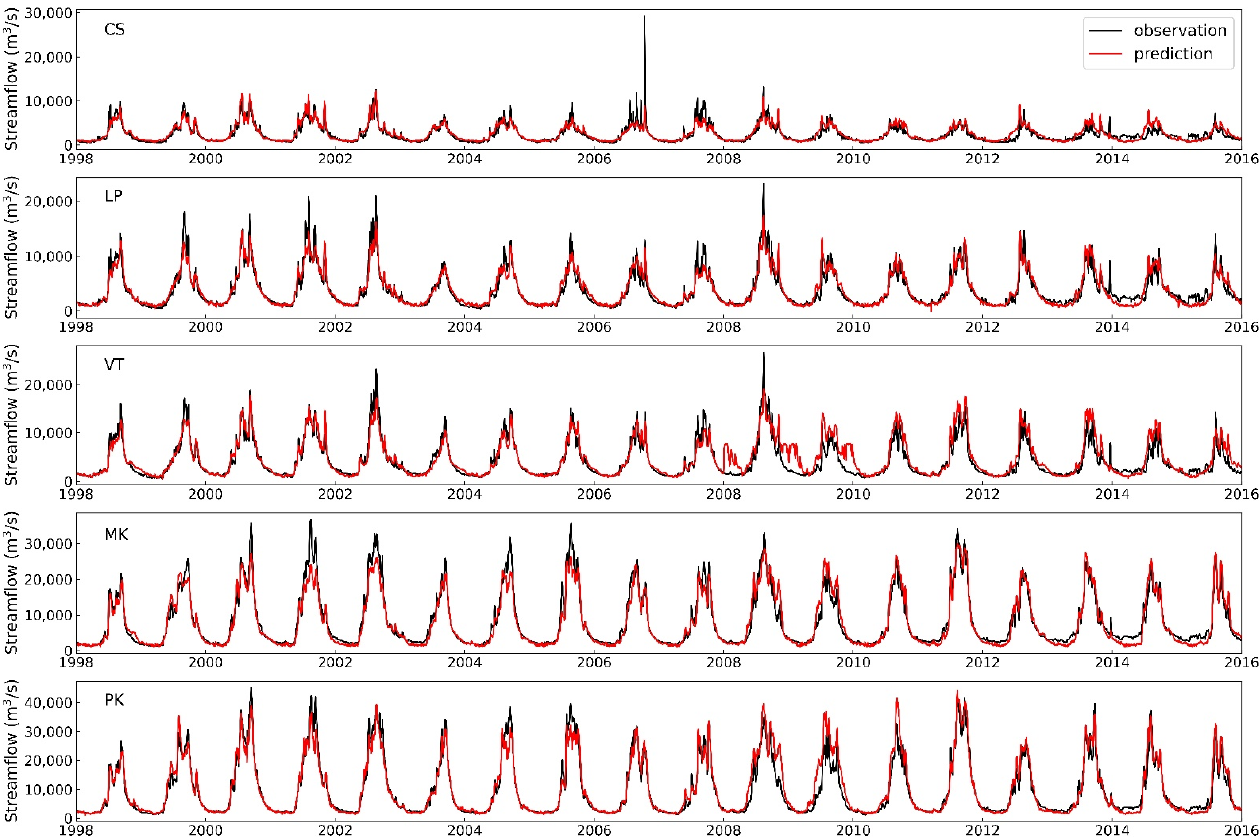
Figure 4. Observed and simulated daily streamflow using HPD model at five hydrological stations from 1998 to 2015 in the LMRB.